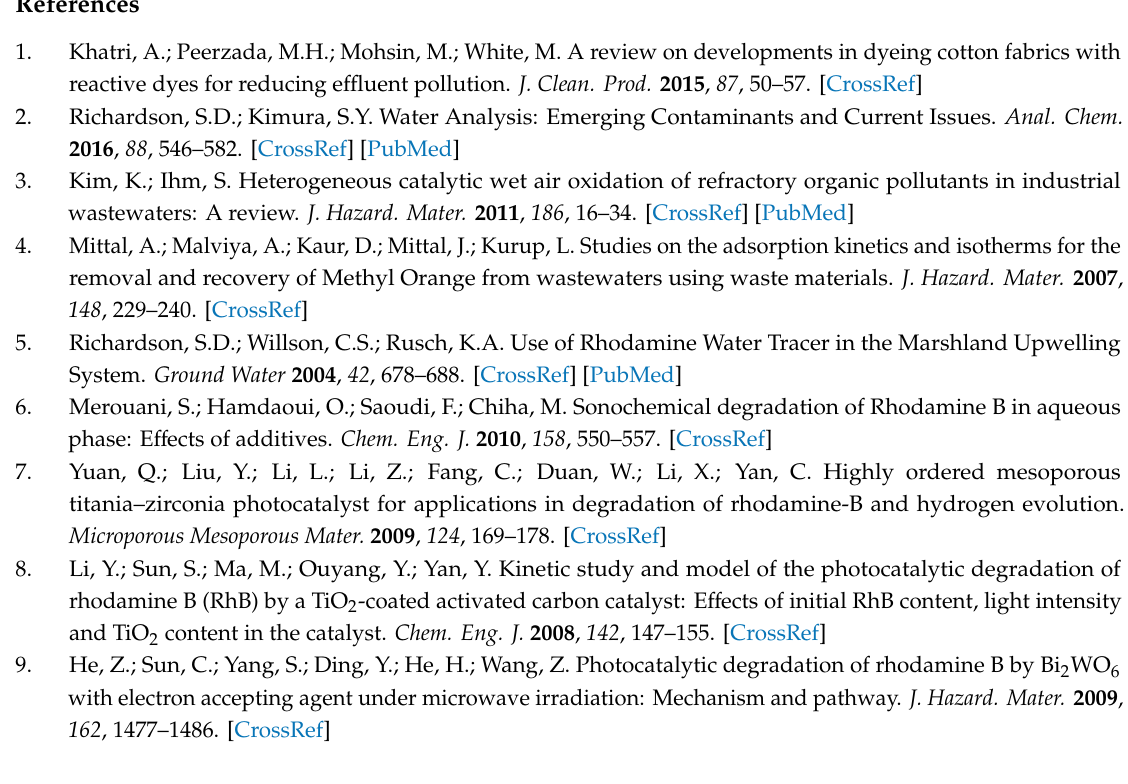
Figure S1: EDS spectrum of AC-700, Figure S2: FTIR spectrum of AC-700, Figure S3: XRD patterns of the fabricated activated carbon, Figure S4: XPS survey spectrum of AC-700, Figure S5: Time dependent UV-vis absorption spectra for the degradation of RhB dye in the presence of di ff erent types of catalyst (a) AC-600 (b) AC-700 (c) AC-800, Figure S6: Time dependent UV-vis absorption spectra for the degradation of RhB dye in the presence of AC-700 at di ff erent pH (a) pH = 3 (b) pH = 5 (c) pH = 7 (d) pH = 10 (e) pH = 11 (f) pH = 12, Figure S7: Time dependent UV-vis absorption spectra for the degradation of RhB dye in the presence of AC-700 with di ff erent concentration of dye (a) 10 mg L − 1 (b) 20 mg L − 1 (c) 30 mg L − 1 (d) 40 mg L − 1 , Figure S8: Time dependent UV-vis absorption spectra for the degradation of RhB dye in the presence of AC-700 with di ff erent amount of catalyst (a) 0.1 g / L (b) 0.2 g / L (c) 0.3 g / L (d) 0.4 g / L, Figure S9: Time dependent UV-vis absorption spectra for the degradation of RhB dye in the presence of AC-700 at di ff erent temperature (a) 25 ◦ C (b) 35 ◦ C (c) 45 ◦ C, Table S1: Elemental